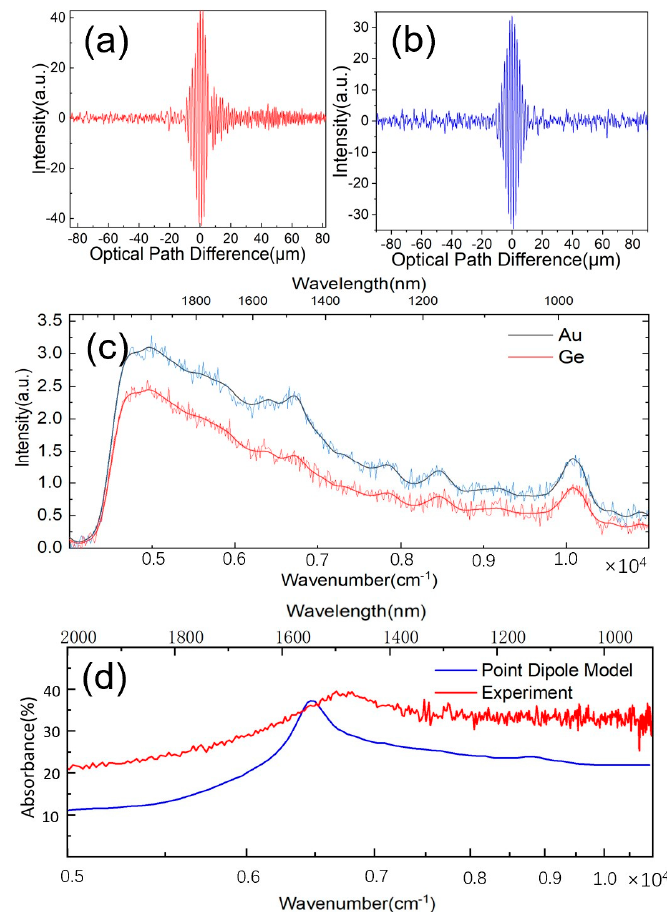
Figure 6. ( a )The interferogram of Au and ( b ) the interferogram of Ge. The interferograms were col- lected at the points when the AFM tip was set in the Au and Ge regions (corresponding to the red and blue points in Figure 4a). All of them were obtained at second harmonic demodulation. ( c ) The near-field spectra of Au (blue line) and Ge (red line) obtained by the fast Fourier transform of the interferograms. ( d ) The red line is the near-field absorption spectrum of Ge normalized to Au ((S 2,Au (v) − S 2,Ge (v))/S 2,Au (v)), and the blue line is the spectrum predicted by the point dipole model.